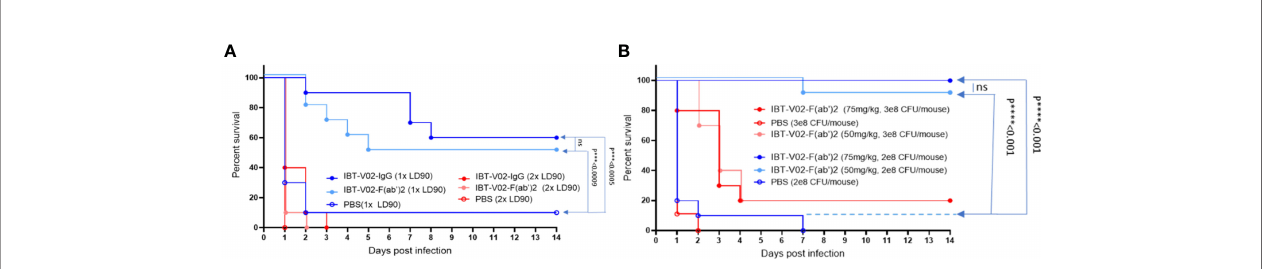
FIGURE 9 | Ef fi cacy studies in BALB/c mice challenged with USA300 (NRS384) in bacteremia model. (A) Comparison of IBT-V02-IgG and IBT-V02-F(ab ’ )2 either at 1xLD90 or at 2xLD90 with different antibody treatment doses. (B) Different treatment doses of IBT-V02-F(ab ’ )2 are compared with two different challenge doses. The